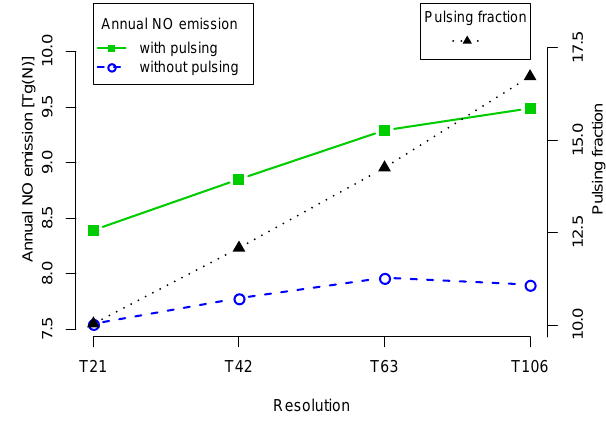
Fig. 6. Change of soil biogenic NO emission with pulsing (green boxes), without pulsing (blue circles), and the pulsing fraction (tri- angles) for the LC simulation at four different horizontal resolu- tions. Table 4. Relative annual underestimation of SNO x in the coarser simulations compared to the T106 resolution of the YL95EMAC and LC simulation. And the remaining deviation after scaling the emission factors by the initial underestimation. The last column lists the global area defined as wet in 10 6 km 2